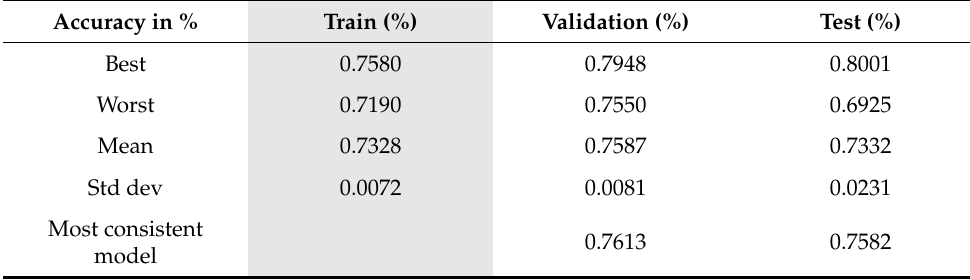
Table 3. Summary table for Approach A3—Hyperband accuracy (in %).